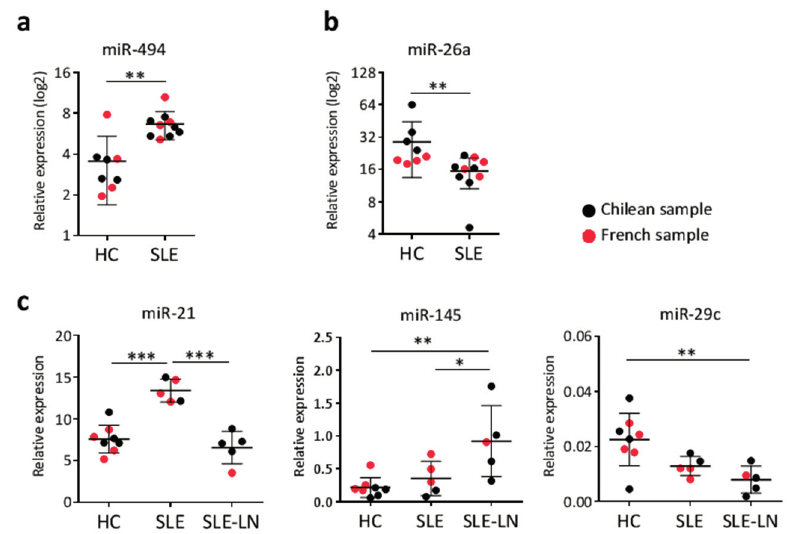
Figure 4. miRNA expression comparison between Chilean and French subjects. The expression level of five miRNAs was detected in CD27 + and CD27 − B cells using real-time RT-PCR. Each dot represents the mean value for CD27 − and CD27 + B cell subsets for each Chilean (black) and French (red) subject. ( a ) miR-494 expression in naive CD27 − B cells of SLE patients versus HC; ( b ) miR-26a expression in memory CD27 + B cells of SLE patients versus HC; ( c ) Expression levels of three different miRNAs that are representative of the three different expression profiles identified for discriminating SLE versus SLE-LN patients: miR-21, miR-145, and miR-29c. Results are expressed as mean ± SD of individual samples for five SLE (three French, two Chilean), five SLE-LN (one French, four Chilean), and eight HC (four French, four Chilean). * p < 0.05, ** p < 0.01, and *** p < 0.001 are plotted